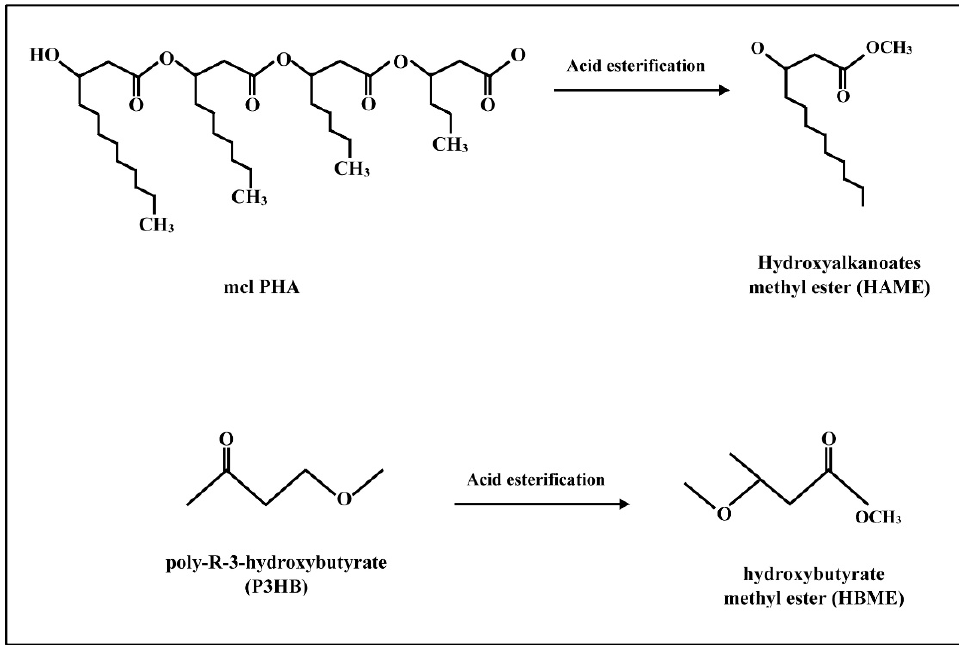
Figure 2. Production of polymeric biodiesel HAME and HBME from mcl PHA and P3HB.